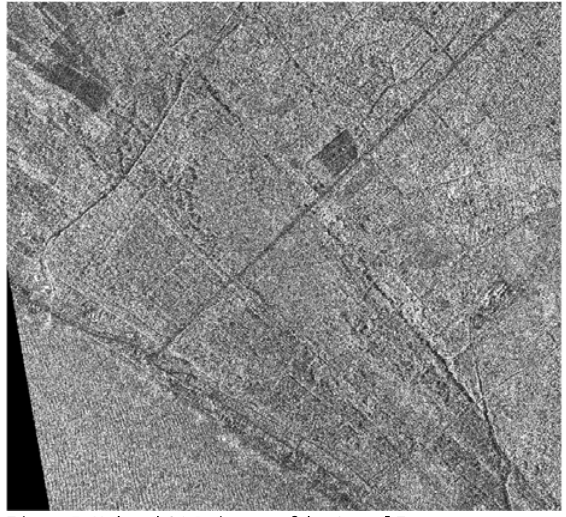
Figure 5. X-band SAR image of the Castel Fusano area